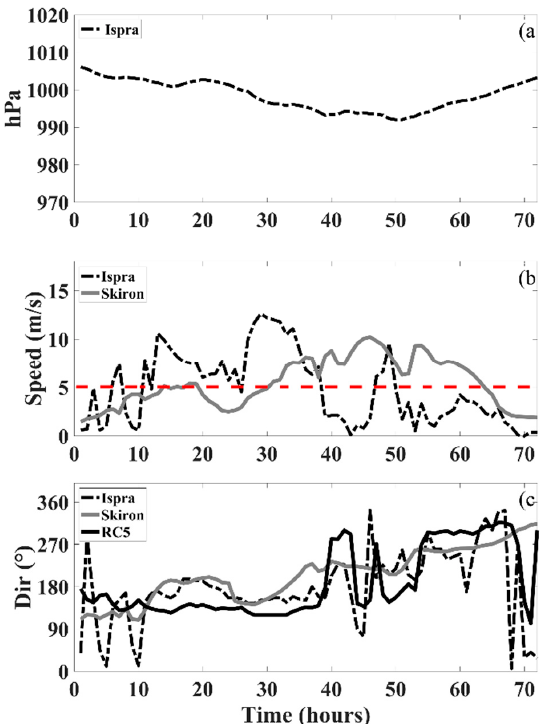
Figure 4. Time series of HFr, ISPRA weather station observations and SKIRON/Eta model data